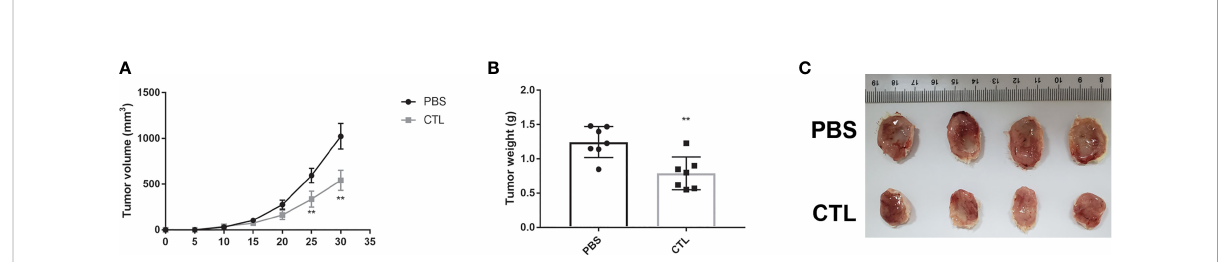
FIGURE 5 Tumor model showed the anti-myeloma effect of the peptide No. 8 speci fi c CTLs in vivo. U266 cells (5 × 10 5 ) were inoculated s.c. into NTG mice (day 0) followed by No. 8 peptide induced CTLs (5 × 10 6 ) or PBS injected intravenously on day 1 and day 7. After the mice were killed in the end point of the experiment (Day 30), the tumors were peeled off, weighed, and photographed. Independent experiment was performed two times. The number of animals in the fi rst experiment was 3 and the second was 4. The results of the two experiments were the same. The summarized results of the two experiments are shown in (A) (the tumor growth curve) and (B) (tumor weights). (C) The results of the second experiment (excised tumors). Two-way-ANOVA showed that the p -value is <0.001 for CTL and PBS in (A) Unpaired t -test was performed to assess the signi fi cance in A and B ** p < 0.01.